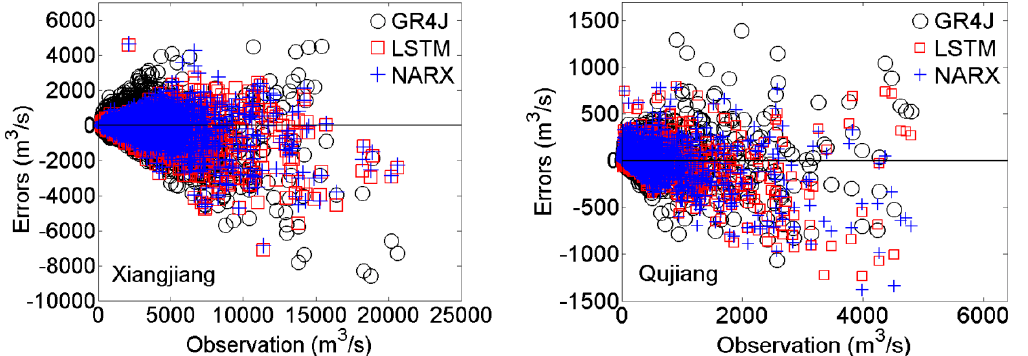
Figure 2. Errors in predicted discharge versus observation given by GR4J, nonlinear autoregressive exogenous inputs neural network (NARX), and long short-term memory (LSTM) for the Xiangjiang and Qujiang basins.